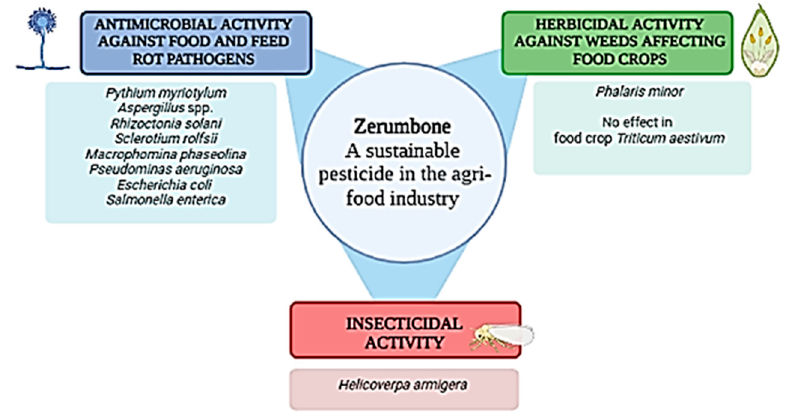
Figure 2. Applications of zerumbone in the agri-food industry.